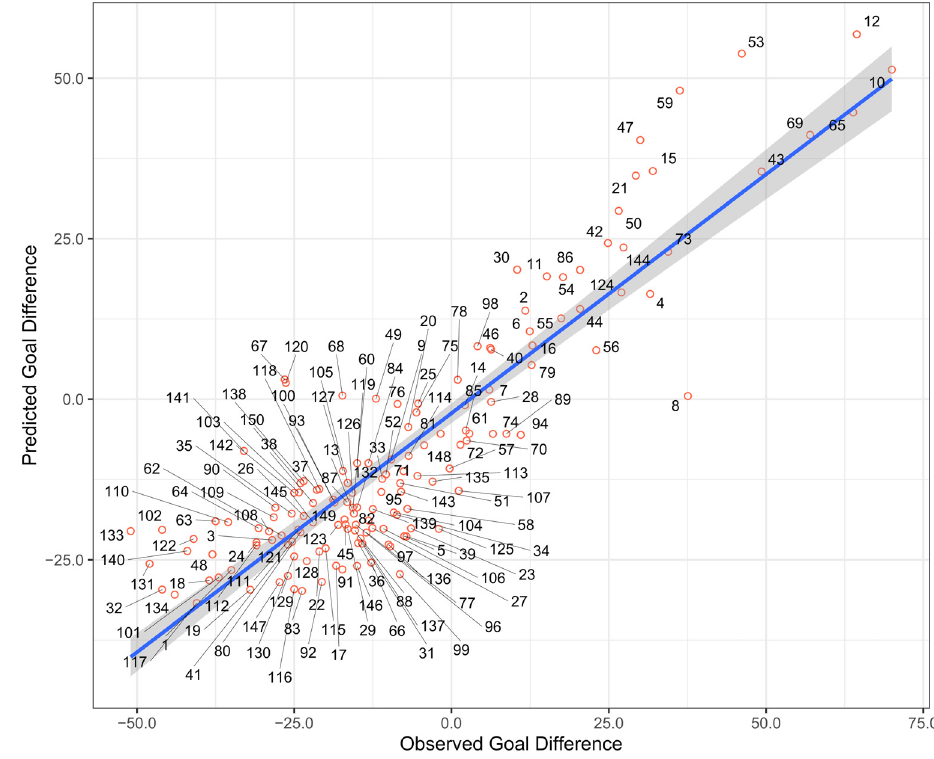
Figure 2. Scatter plot of predicted goal difference versus actual goal difference for the refined random forest regression model.